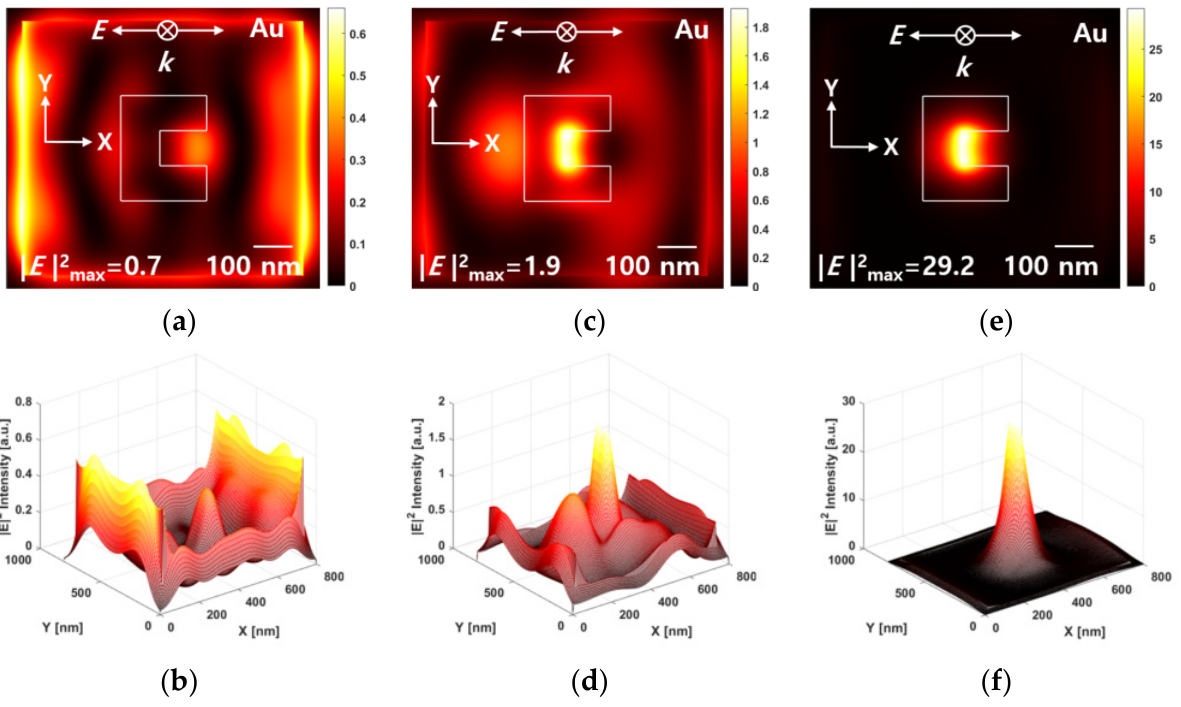
Figure 4. Near-field | E | 2 intensity distribution and beam profile in the x-y plane at a distance of 30 nm from the exit plane of ridge-type nanoaperture. ( a , b ) at λ = 405 nm. ( c , d ) at λ = 658 nm. ( e , f ) at λ = 780